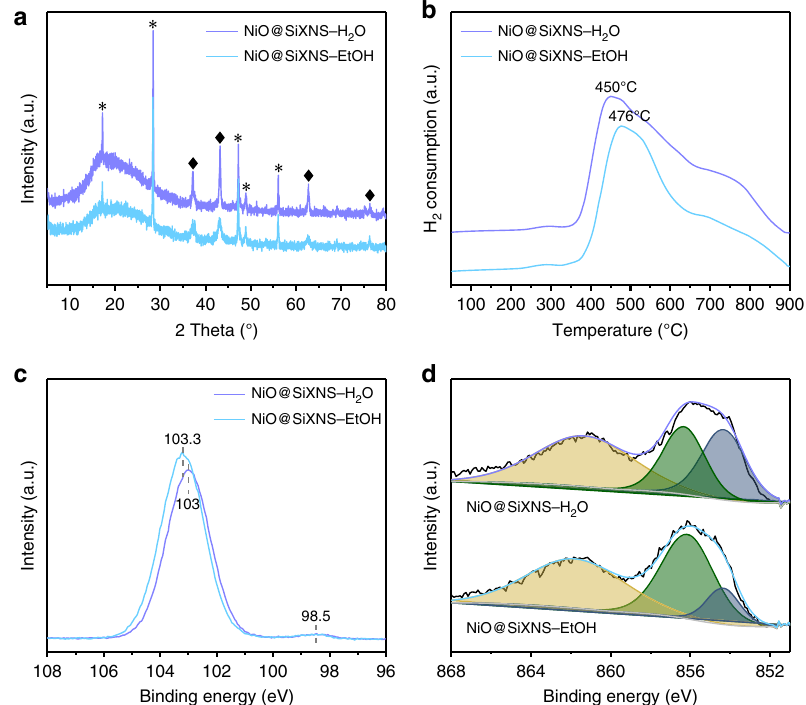
Fig. 2 Characterization of NiO@SiXNS materials. a PXRD patterns showing characteristic peaks from the (*) SiXNS and ( ♦ ) NiO constituents of the composite materials. b H 2 – TPR (hydrogen temperature programmed reduction) plots indicating the appreciable difference in the onset of NiO reduction on heating under a hydrogen atmosphere. c , d XPS spectra illustrating the differences in the local bonding environments of c Si 2 p and d Ni 2 p 3/2 obtained from of NiO@SiXNS samples (green peak refers to NiSiO 3 , cyan peak corresponds to NiO, and yellow one is the satellite